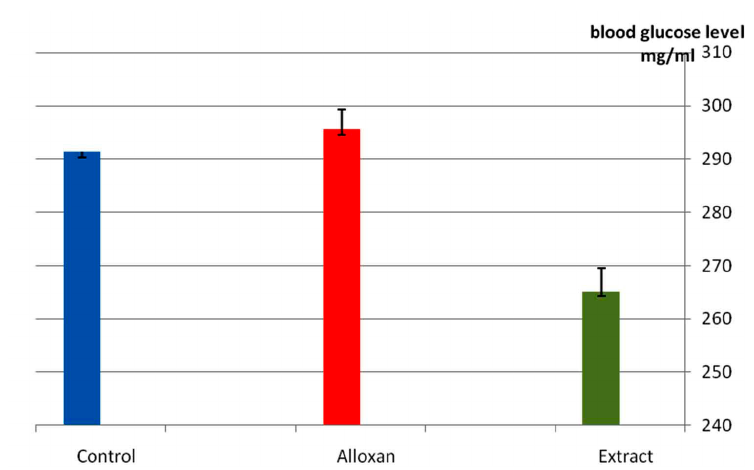
Fig. 2. Effect of the extract in blood glucose level of laboratory rats after 3hrs of treatment n=5